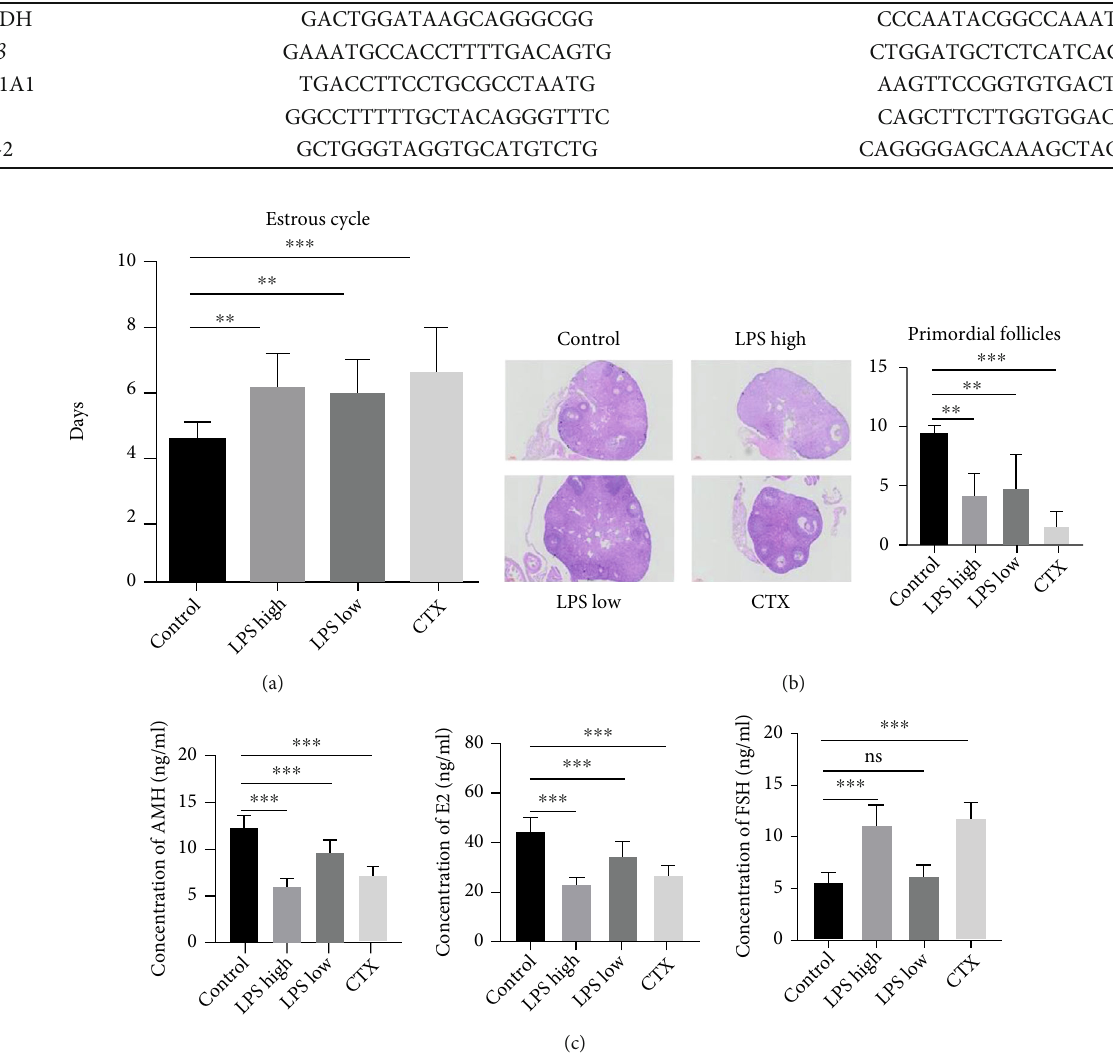
Figure 1: Lipopolysaccharide- (LPS-) induced ovarian dysfunction in mice. C57BL/6N female mice (6- to 8-week-old) were intraperitoneally injected with control, low-dose LPS (0.5 mg/kg once daily), high-dose LPS (2.5 mg/kg twice weekly), or cyclophosphamide (CTX; 150mg/kg once weekly) for 2 weeks. (a) The lengths of estrous cycles were determined by daily observations of vaginal epithelial cell cytology. (b) Hematoxylin and eosin staining was performed to count primordial follicles (black arrow). Scale bar: 100 μ m. (c) Enzyme-linked immunosorbent assay (ELISA) was conducted to measure the levels of serum AMH, E2, and FSH at 2 weeks after treatment. Data are expressed as the mean ± standarderror of the mean (SEM). ∗∗ P < 0 : 01 and ∗∗∗ P < 0 : 001 ; ns: nonsigni fi cant; n = 10